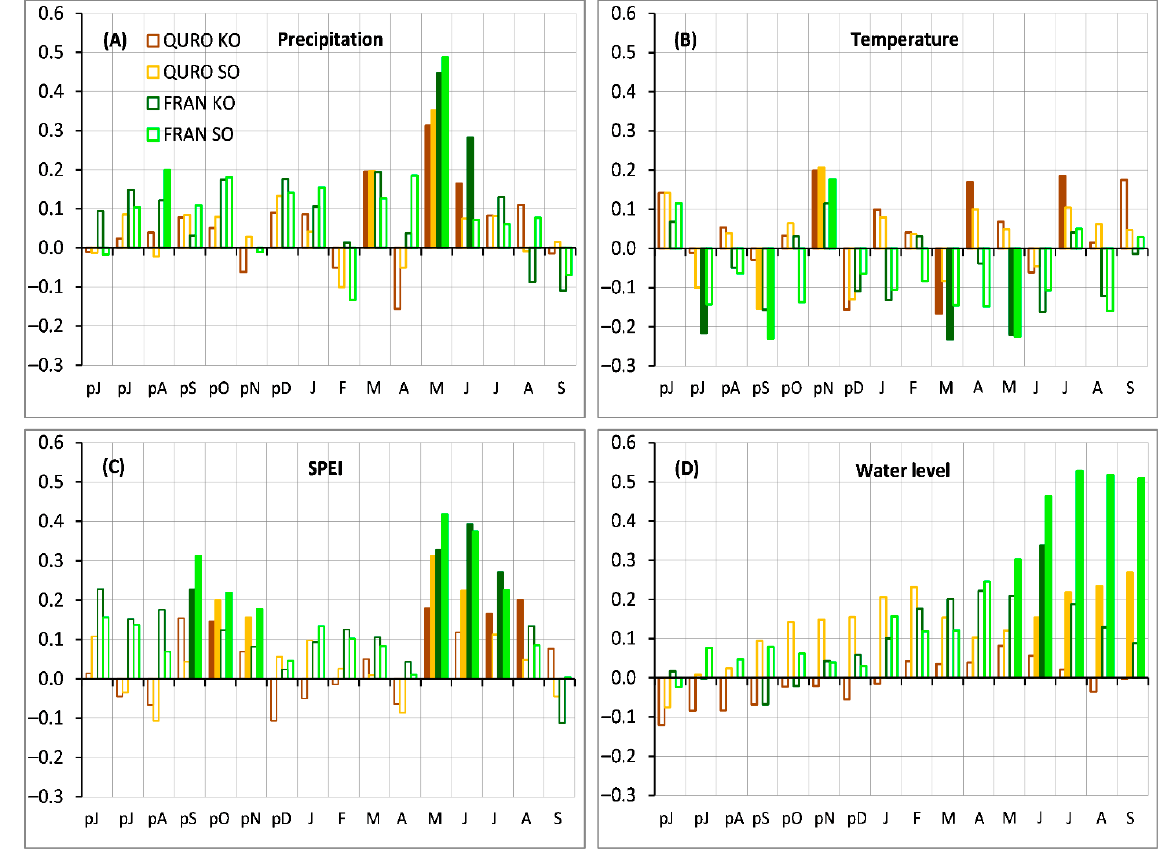
Figure 3. Bootstrapped correlation coefficients between the monthly resolved: ( A ) precipitation, ( B ) temperature, ( C ) three- month standardized precipitation evapotranspiration index—SPEI, and ( D ) groundwater level and ring width indices (RWI30) of the standard chronologies. Filled bars correspond to statistically significant ( p < 0.05) correlation coefficients. Species abbreviations: QURO— Quercus robur and FRAN —Fraxinus angustifolia ; site designations: KO and SO.